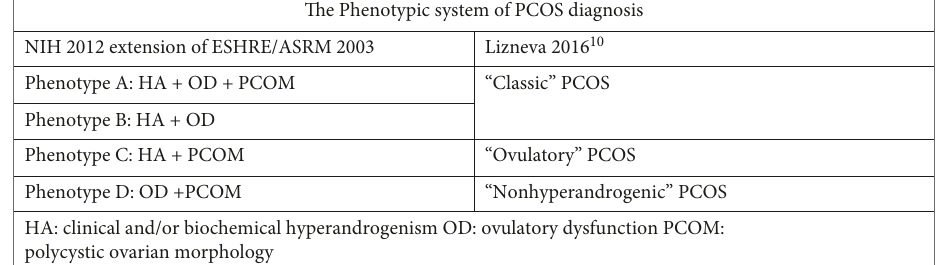
Figure 1: Diagnostic criteria for polycystic ovary syndrome